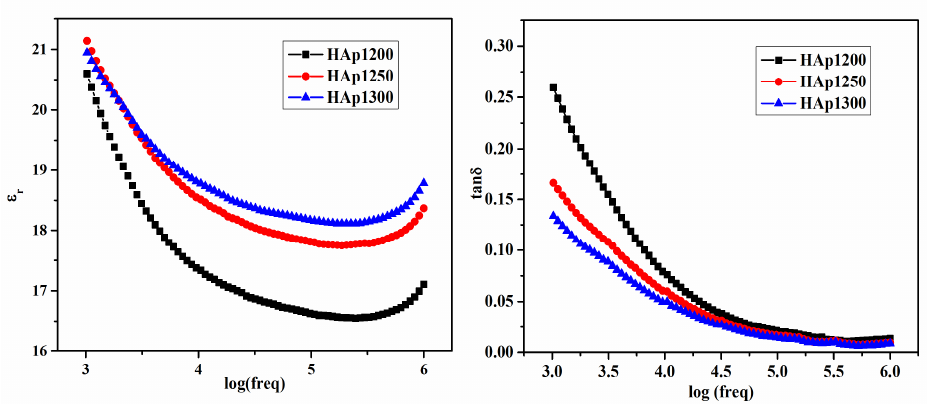
Figure 5. Variation in εr and tanδ with frequency at room temperature of sintered HAp samples. It was observed that, at room temperature, with the increase in sintering temperature, ε r increased and tanδ decreased. The simultaneous improvement of ε r and the decrease in tanδ with the increase in sintering temperature can be related to the density and the grain size of the sintered HAp samples [31]. In the present study, it was observed that ε r and tanδ of HAp1300 and HAp1250 samples were nearly equal. A high tanδ was found in the